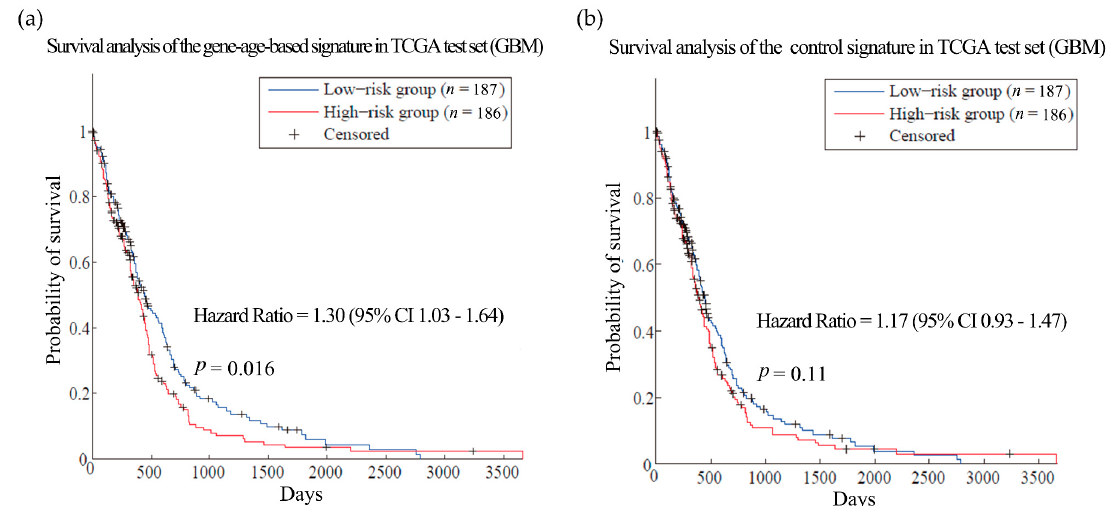
Figure 5. Survival analysis of the glioblastoma multiforme dataset. ( a ) and ( b ) are the predictions of the glioblastoma multiforme (GBM) prognosis model using gene-age-based signatures and control signatures in independent test sets in the GBM TCGA dataset separately. TCGA: The Cancer Genome Atlas.